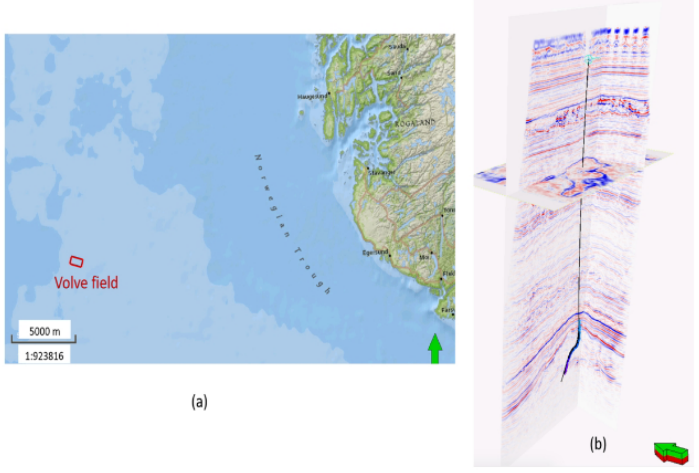
Figure 6. ( a ) Volve field highlighted on a map of the offshore North Sea. ( b ) Seismic data highlighting a well trajectory from the Volve field. Source: extracted from [10].